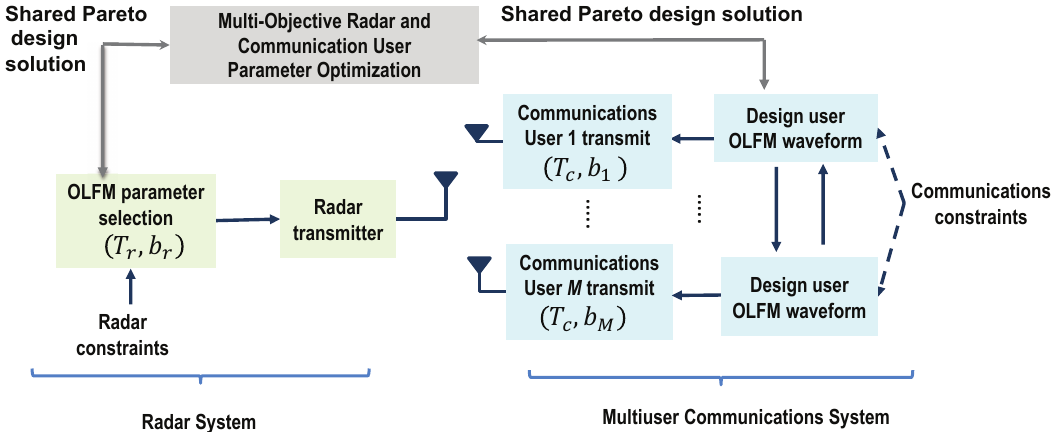
Figure 7. Block diagram overview of coexistence waveform design Approach II: Pareto optimization is used to jointly optimize the OLFM waveform parameters of both systems; the designed parameters are relayed to both the radar and communications